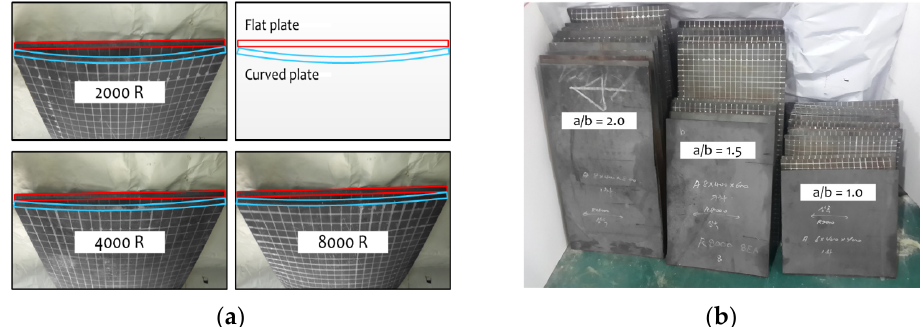
Figure 4. ( a ) Curved plates specimens and ( b ) test plates after buckling test.